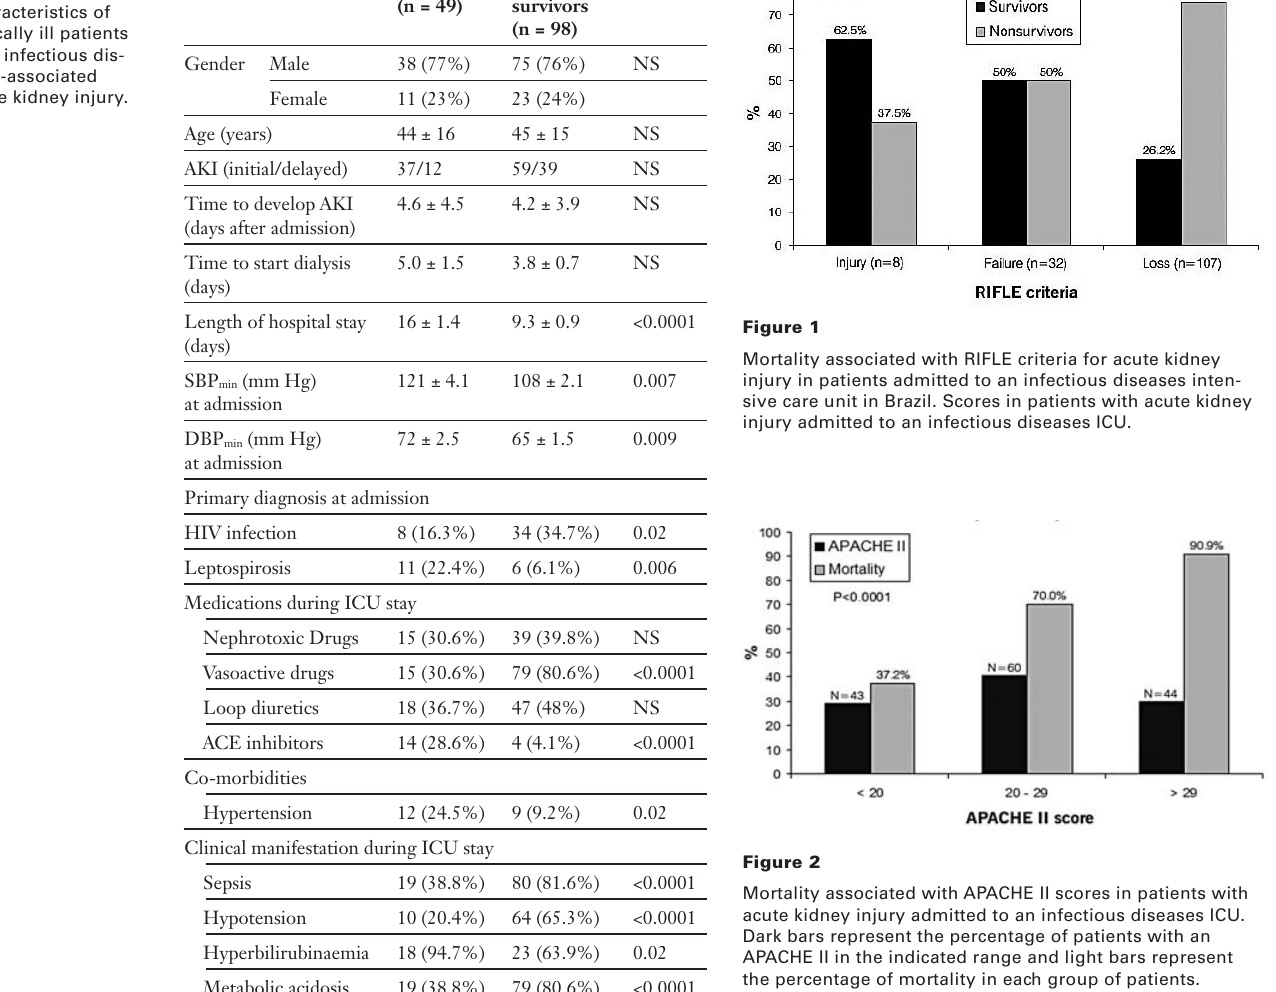
Table 1 Characteristics of critically ill patients with infectious dis- ease-associated acute kidney